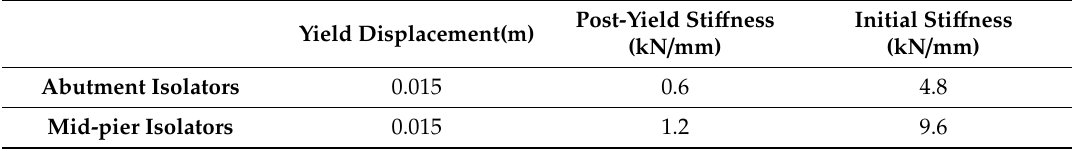
Table 3. Lead rubber bearing (LRB) characteristics of the benchmark bridge.